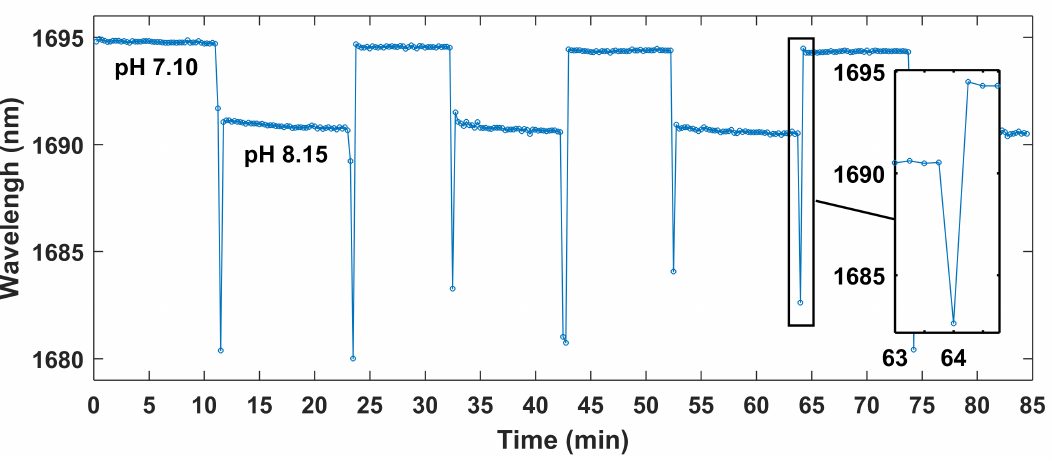
Figure 10. Wavelength of the central minima as a function of time for a sensor repeatedly submerged in pH-levels of 7.10 and